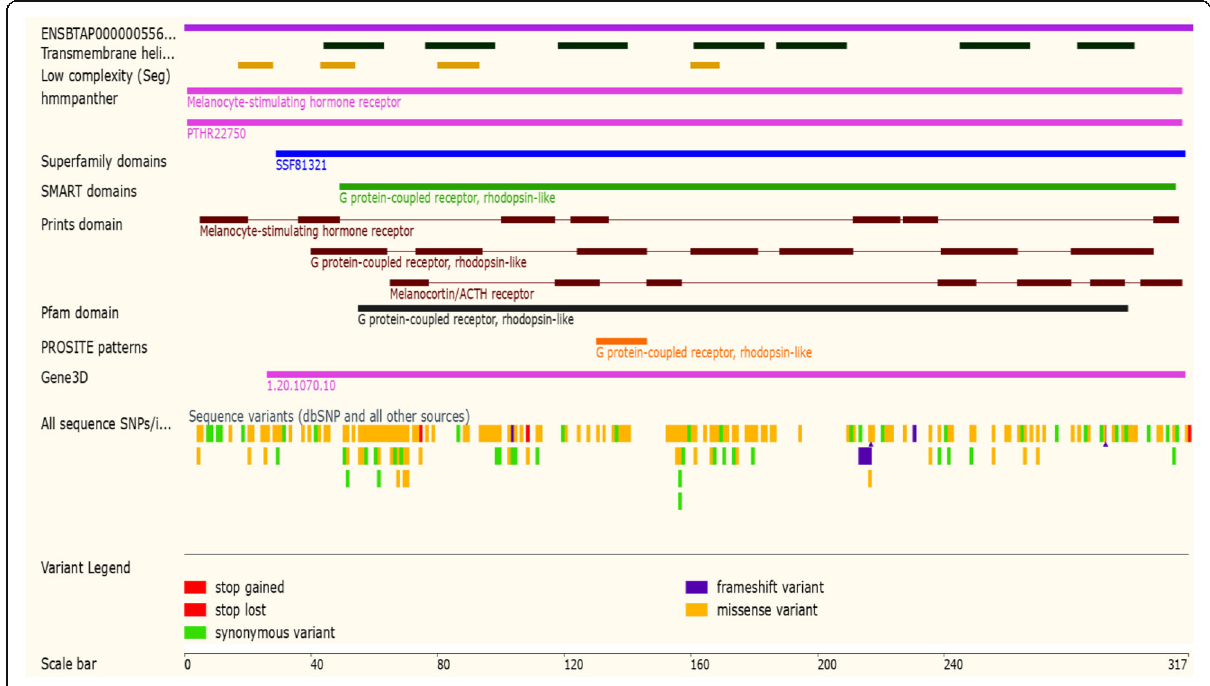
Fig. 6 MC1R gene protein domains of the